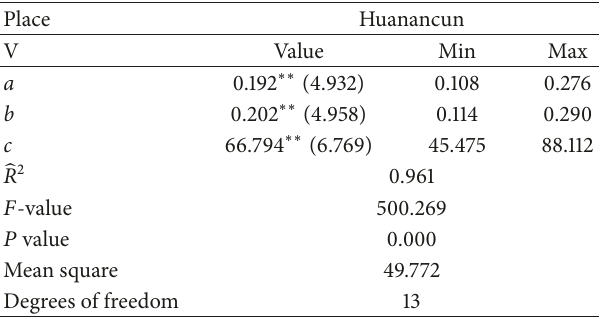
Table 12: Fitting parameters of empirical model on H-5 by sieve- pipette method.